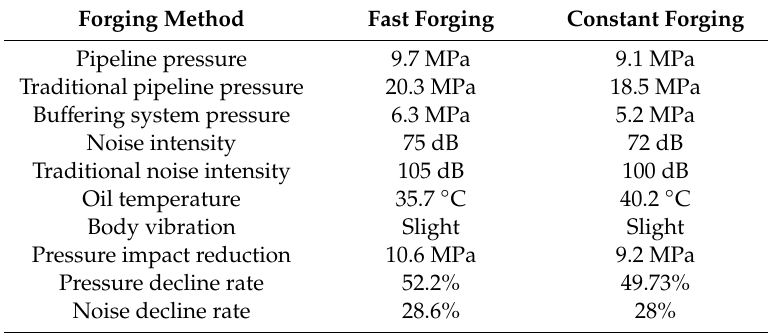
Table 3. Results of the experiments at the unloading stage for di ff erent forging methods.